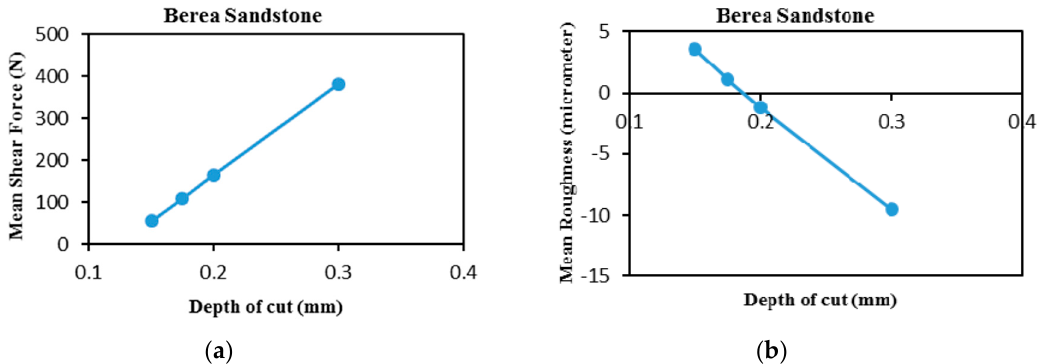
Figure 11. Evolution of mean shear force and mean surface roughness versus DOC: ( a ) mean shear force; ( b ) mean groove roughness.